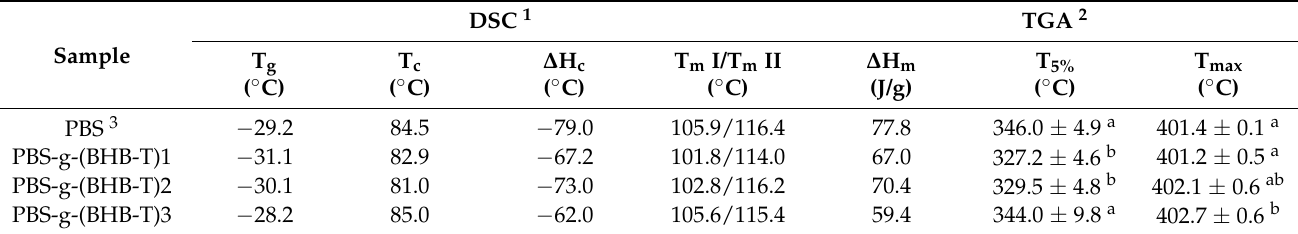
Table 2. Thermal properties of PBS and functionalized PBS